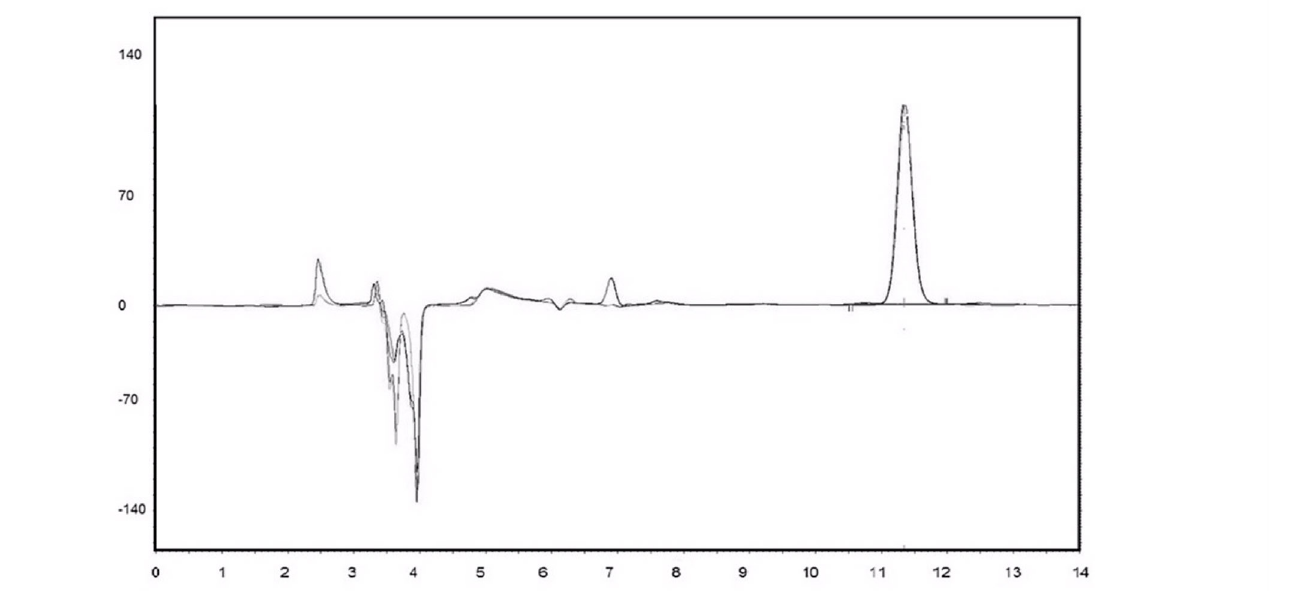
FIGURE 1 - Overlapped chromatograms obtained during selectivity study, under experimental